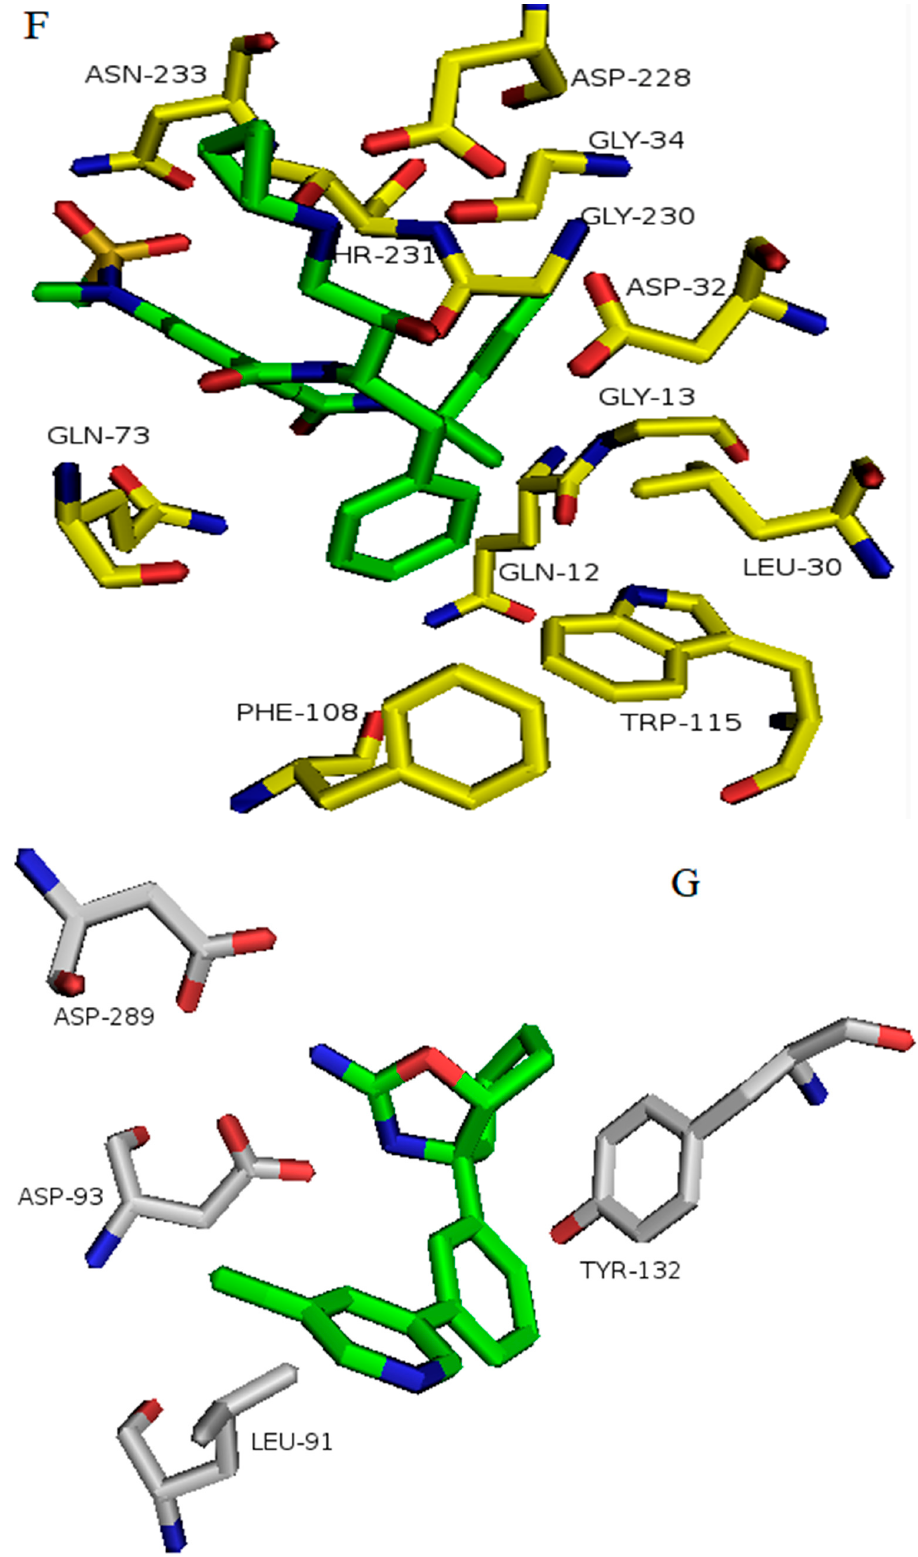
Figure 9. Binding of inhibitors to BACE1 obtained from average structures after MD simulation software. Structures are defined by their PDB ID of complexes of BACE1 and the inhibitor: ( A ) 5i3X-68J (1); ( B ) 5i3Y-68K (2); ( C ) 5i3V-69M (4); ( D ) 5ie1-6BS (3); ( E ) 5i3W-68L (5); ( F ) 3TPP-5HA (7); ( G ) 4LC7 = 1WP (6). Inhibitor numbers in brackets from Figure 2, see also Figures S1–S8.